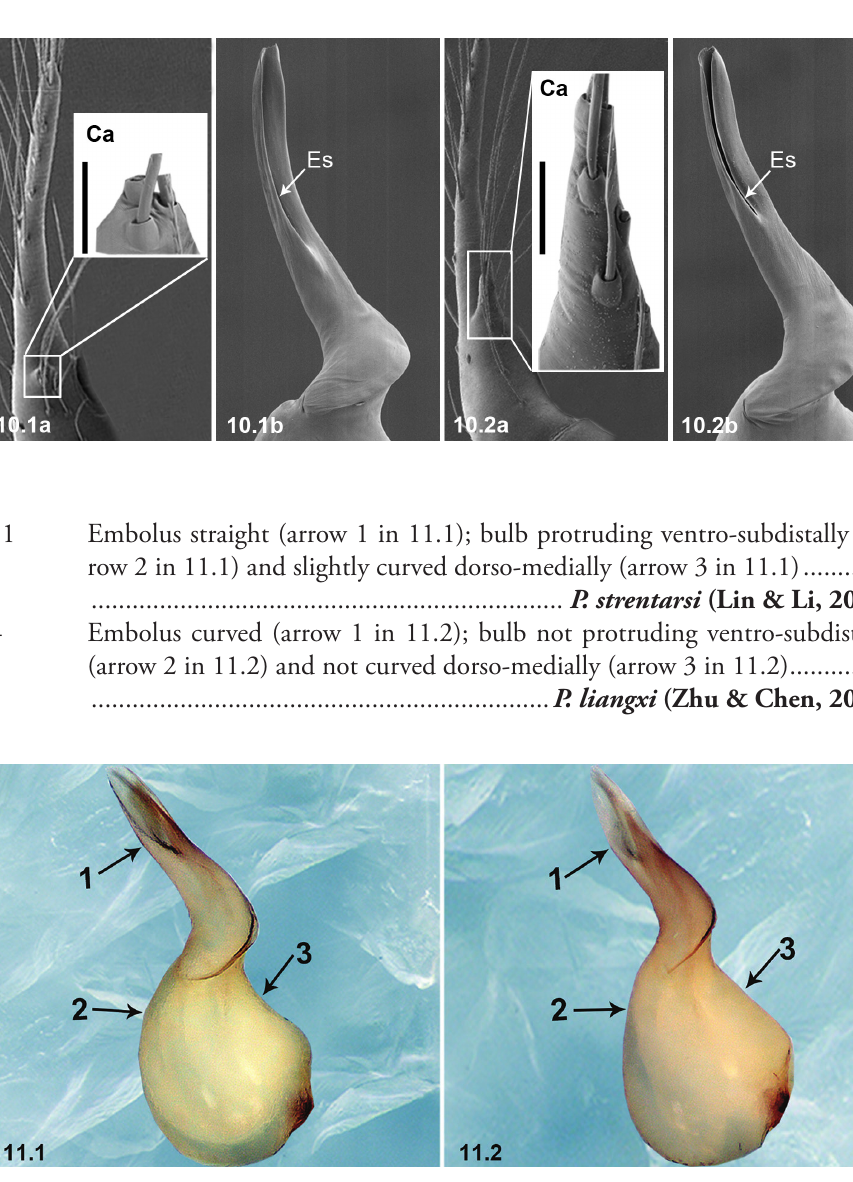
Ca short (10.1a, scale bar 0.2 mm); Esl/El ratio: 058–0.63 (n = 4, mean – Ca long (10.2a, scale bar 0.2 mm); Esl/El ratio: 050–0.52 (n = 5, mean